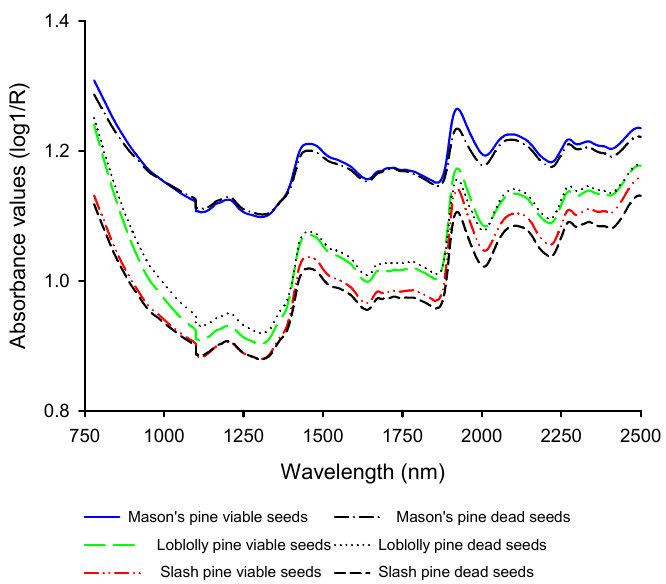
Figure 1. Average uncorrected near infrared (NIR) spectra of viable and dead-filled seeds of Mason’s pine, loblolly pine and slash